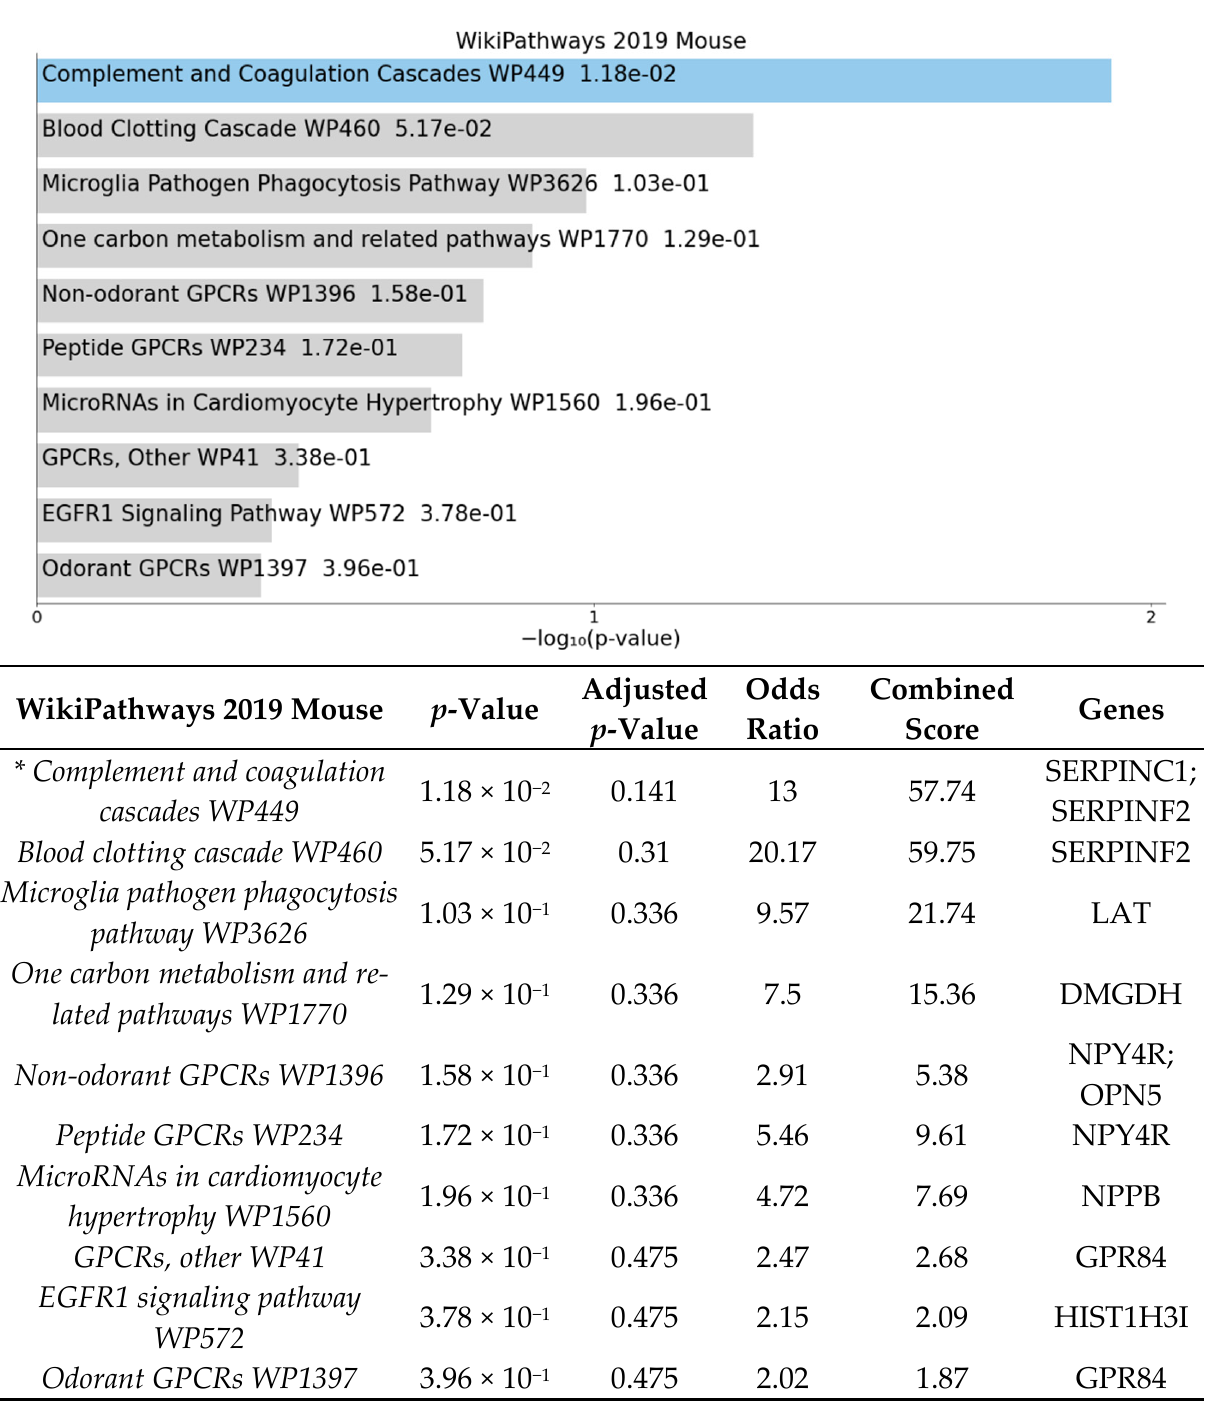
Figure 2. Gene list enrichment analysis of significant DEGs between GF-HFD mice ( n = 4) and GF-ND mice ( n = 4) using EnrichR. The bar graph shows a ranked list by p -value of the top 10 over-represented mouse pathways with significant pathways indicated in blue ( p -value < 0.05). The corresponding table demonstrates detailed statistics and involved genes with significant pathways indicated by an asterisk ( p -value < 0.05).